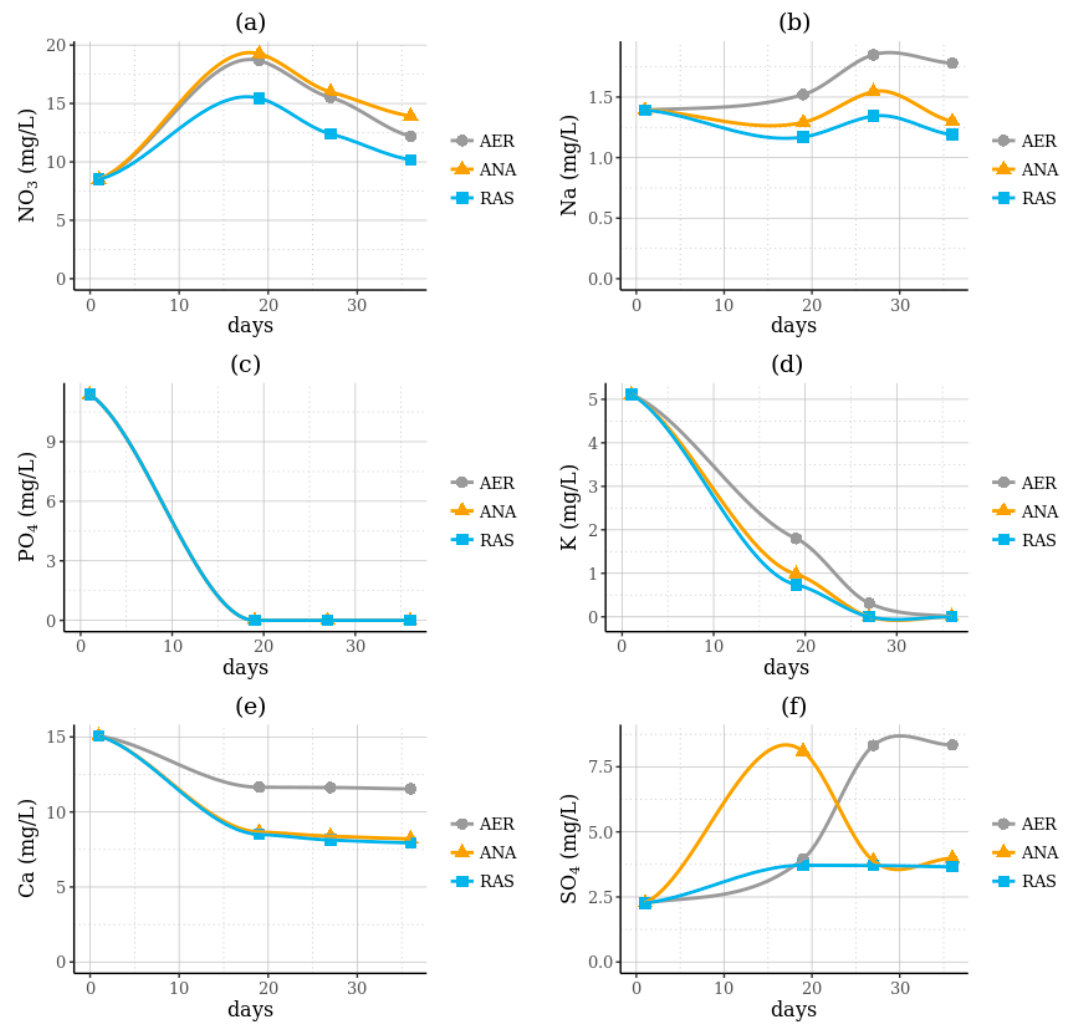
Figure 3. Concentrations of ( a ) nitrate; ( b ) sodium; ( c ) phosphate; ( d ) potassium; ( e ) calcium; and ( f ) sulfate in the sump of the aerobic (AER), anaerobic (ANA), and RAS systems over the 35-day experimental period.